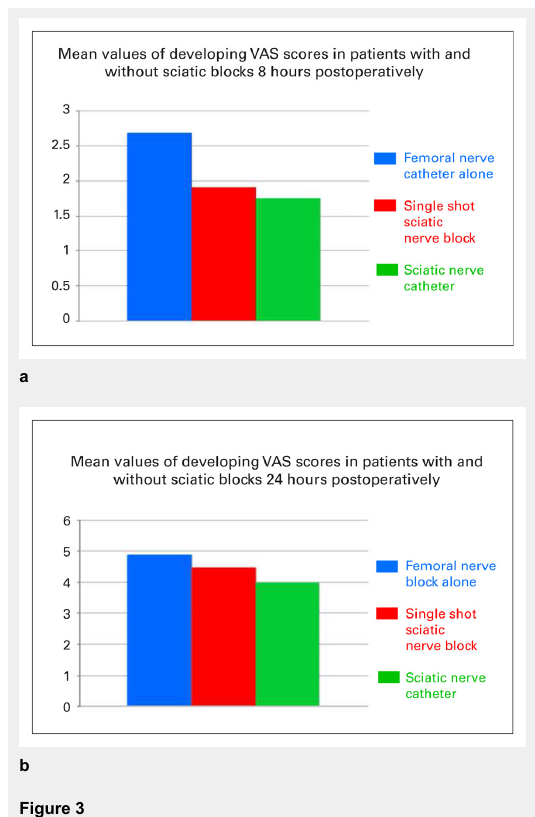
Mean values of developing VAS scores in patients with and without a sciatic blocks at 8 hours (a, above) and 24 hours (b, below) postoperatively.